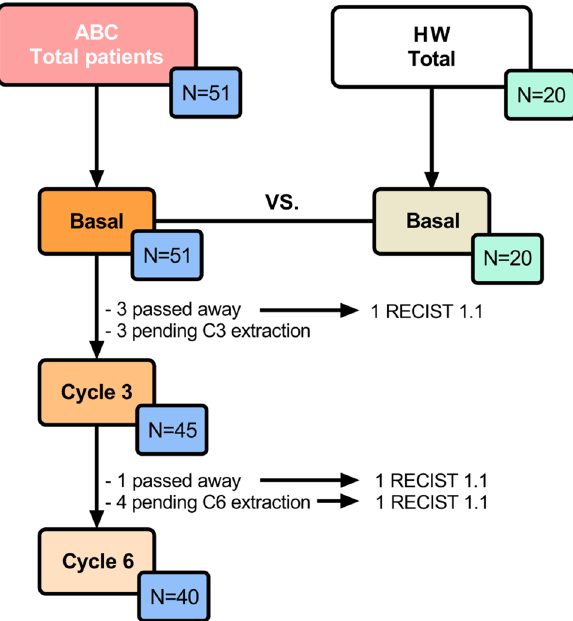
Figure 2. Diagram. HW, healthy women; ABC, advanced breast cancer; RECIST v1.1, response evaluation criteria in solid